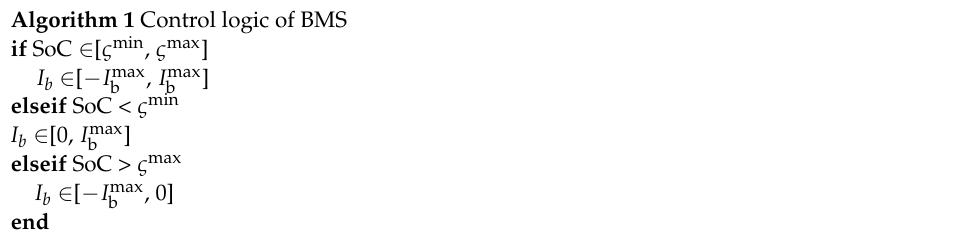
Algorithm 1 Control logic of BMS